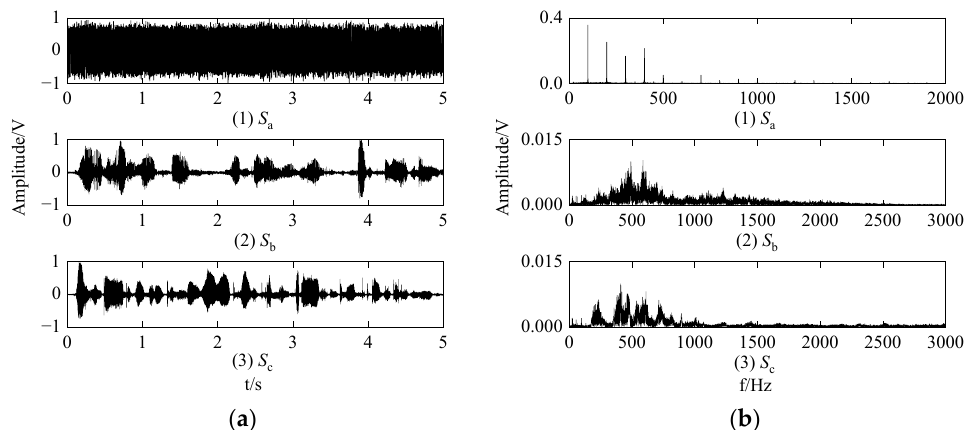
Figure 8. Waveforms and spectrums of three recovered signals of simulation; (( a ): waveforms; ( b ): spectrums.).